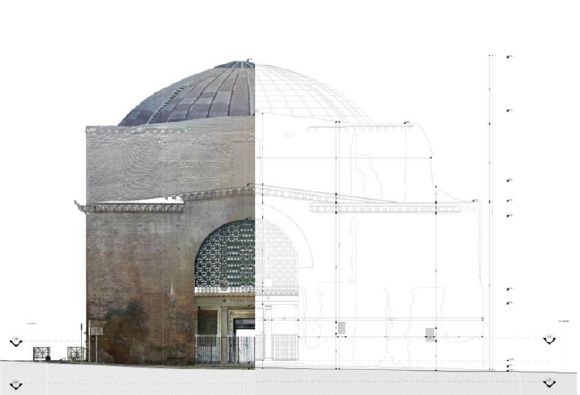
Figure 11 . On the left the orthophotoplane of section 1-1' obtained from the point cloud, on the right the two-dimensional vector elaboration, traced in CAD directly on the point cloud and projecting the design on a single projection Figure 10 . Seven of the nine sections made for an elevation understanding of the site. The elevations shown refer to the 0 elevation of the octagonal classroom. The sections in the image are represented on a scale of 1: 200 and are aimed at the general understanding of the site.